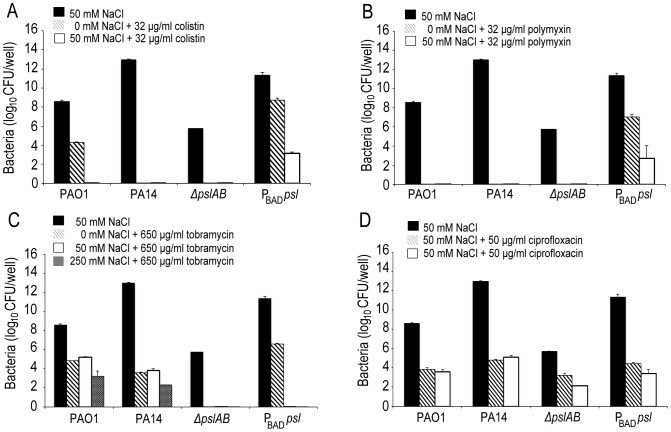
Ionic strength of the challenge medium influences biofilm susceptibility to positively charged antibiotics.Bacterial survival was assessed for WT PAO1, PA14, ΔpslAB, and P
BAD-psl after exposure to colistin (A), polymyxin B (B), tobramycin (C), and ciprofloxacin (D) in the presence or without NaCl. By increasing the ionic strength of the challenge medium with NaCl, electrostatic interactions are predicted to be reduced, leading to an increased efficacy of the positively charged antibiotics colistin, polymyxin B, and tobramycin, but not of ciprofloxacin. Error bars represent SD (n = 3).